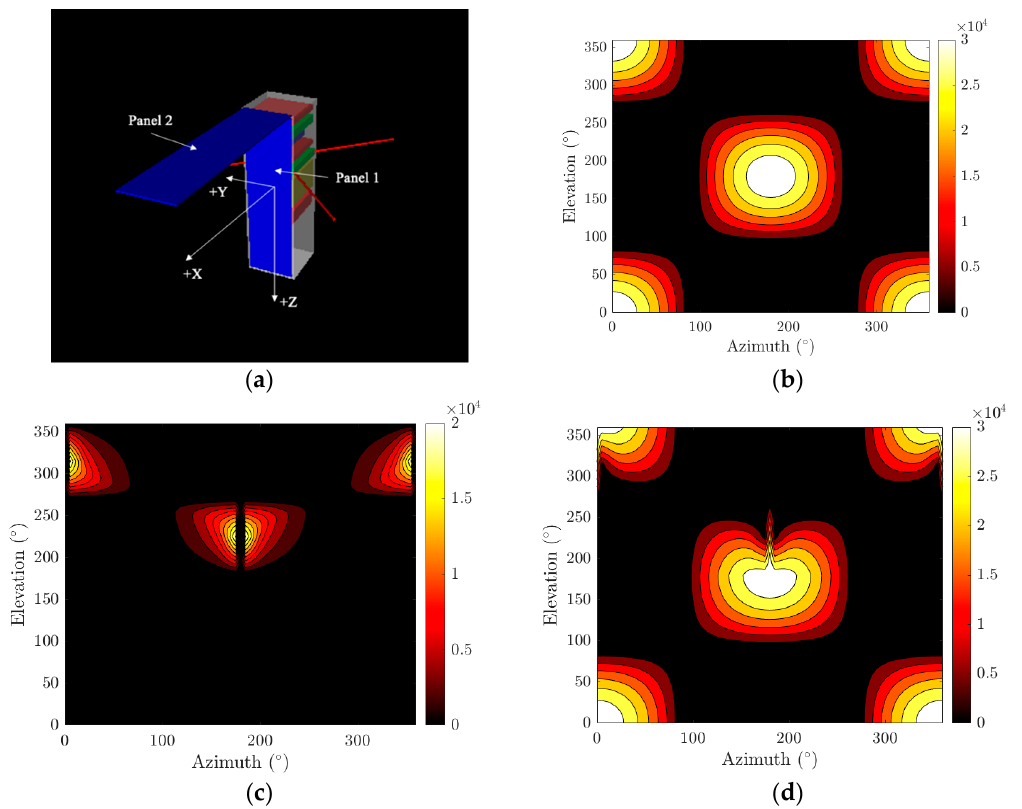
Figure 8. Solar panel exposed area ( a ) CubeSat model with two panels for simulation; ( b ) exposed area of panel 1 without panel 2; ( c ) projected shadow cast by panel 2 on panel 1; ( d ) total exposed area of panel 1. All areas are in mm 2